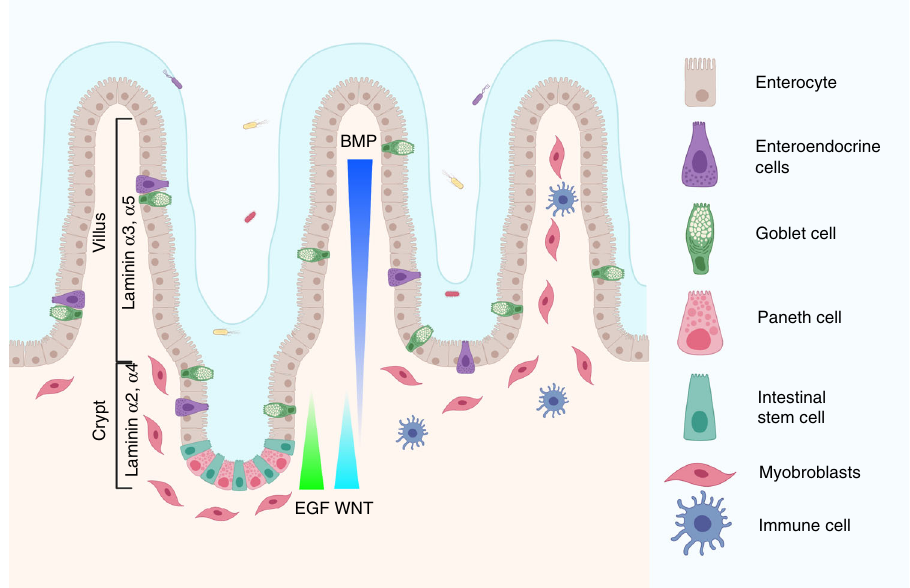
Fig. 1 Structure of the small intestine. The intestinal topography includes villi, where the absorptive enterocytes, secretory enteroendocrine and goblet cells reside, and crypt domains harbouring the intestinal stem cell niche including stem cells and Paneth cells. Underlying mesenchymal cells like myo fi broblasts support the epithelium by secreting important growth factors such as WNTs, R-spondins and BMP antagonists. Gradients are believed to exist for the factors promoting stem cell self-renewal, including WNT and ligands for the ErbB pathway, whereas opposing gradients exist for differentiation-promoting factors such as BMP. The gradient, indicated here for EGF, represents all the ligands of the family, including Nrg1, Areg, Hbegf and Ereg 107 – 109 , which support intestinal stem cell function. Many immune cells also reside in the intestine, constantly monitoring microbe and food antigens. Created with